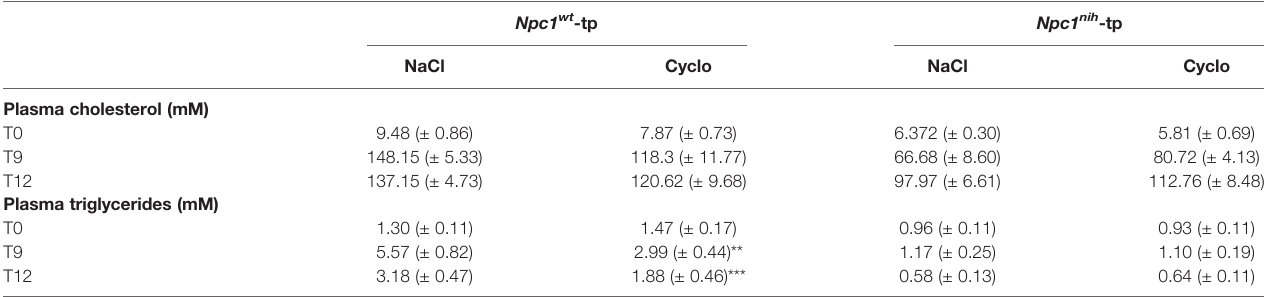
TABLE 1 | Plasma total cholesterol and triglyceride